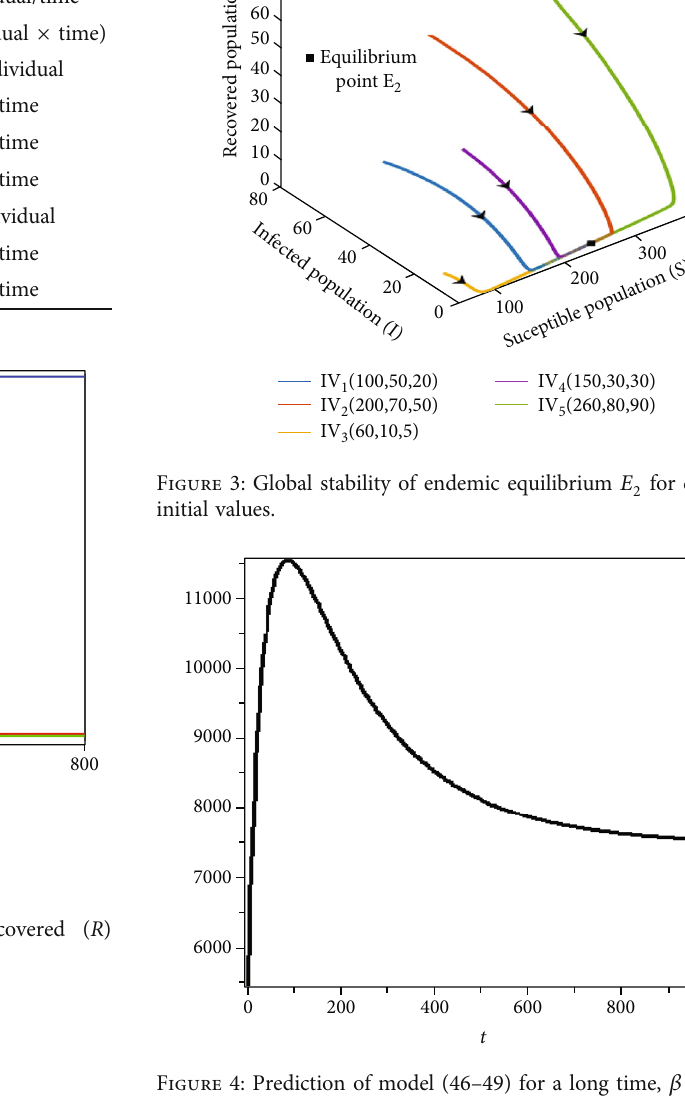
Figure 4: Prediction of model (46 – 49) for a long time, β = 2 : 79 : 1 0 − 7 and R = 1 : 108 0